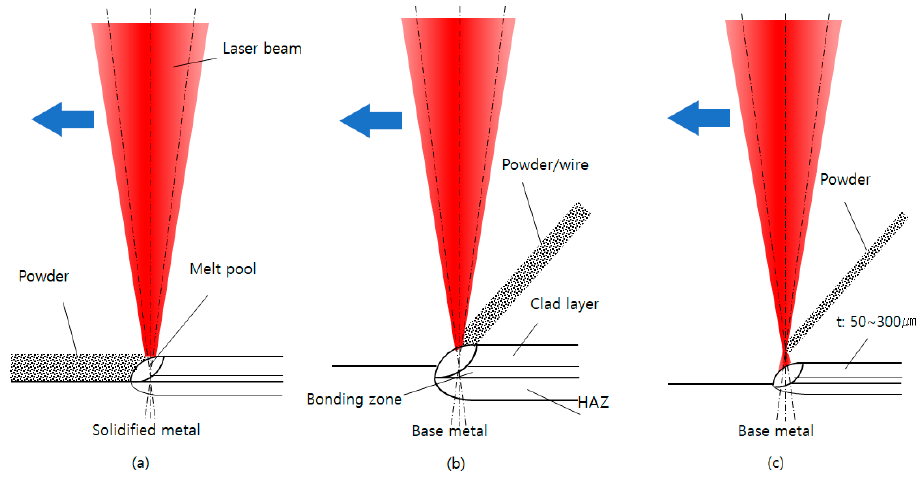
Figure 1. Schematic diagrams of metal AM processes: ( a ) PBF; ( b ) DED; ( c ) thin-DED.